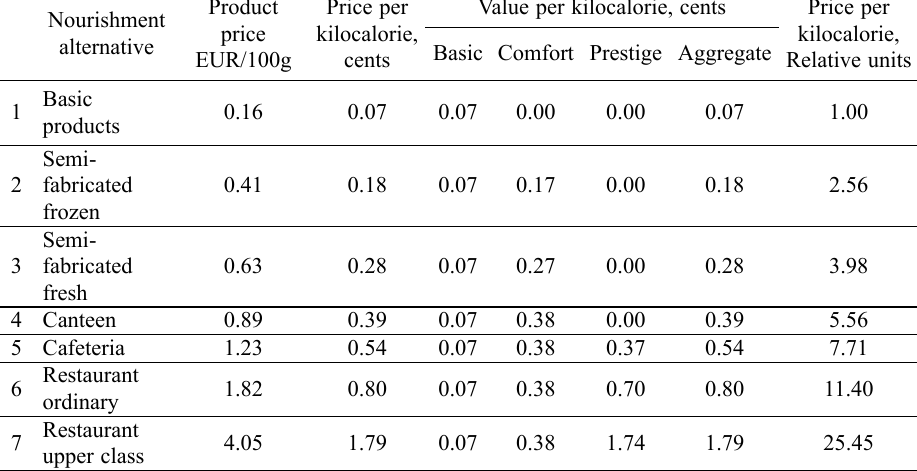
Table 2. Effect of value components on aggregate price of the dish having same nutritional value